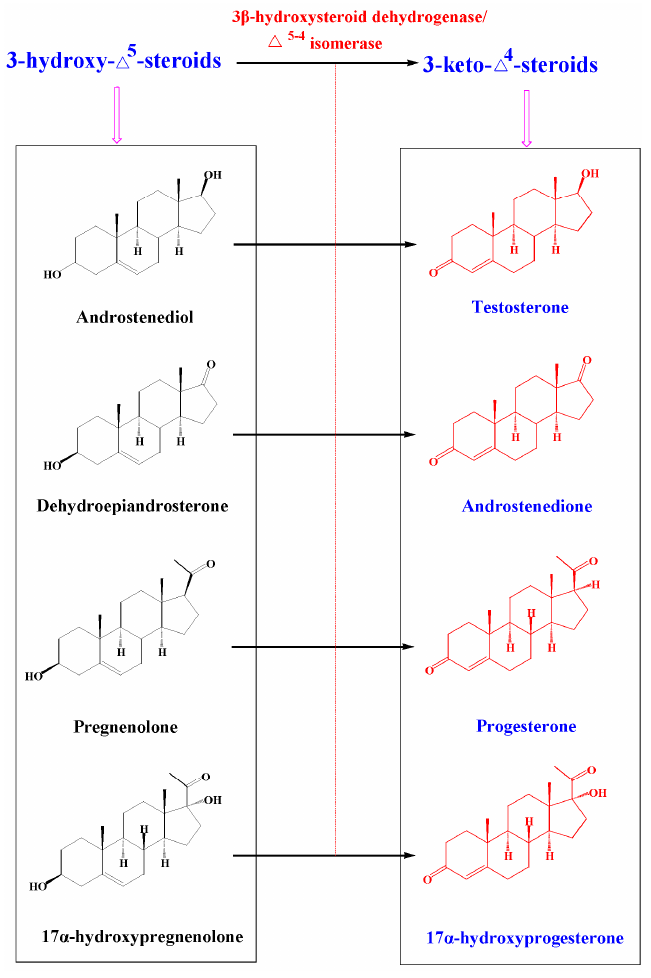
Figure 7. 3-keto- Δ 4 -steroids and 3-hydroxy- Δ 5 -steroids used in this study.